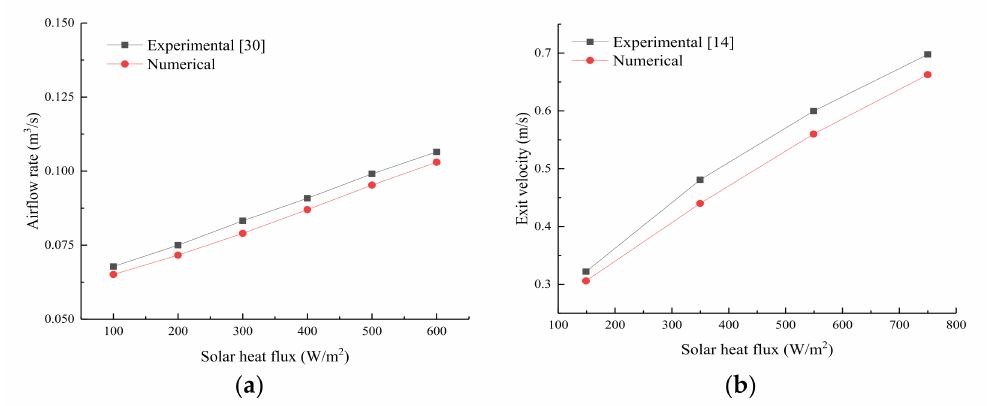
Figure 3. The comparison of the simulation data and the experimental data: ( a ) a Trombe wall [30] and ( b ) an inclined solar chimney at 45 ◦